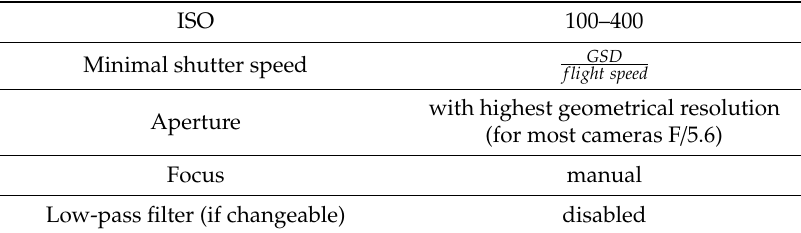
Table 1. Recommended camera settings.